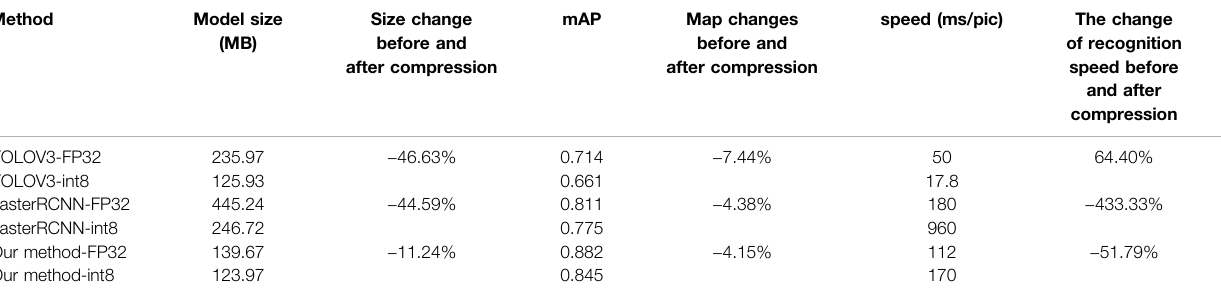
TABLE 6 | Performance comparison of model before and after quantization compression.